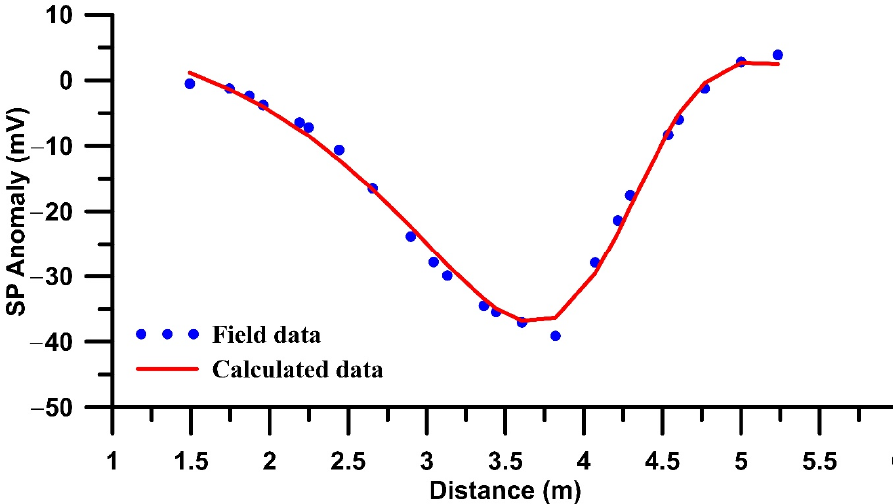
Figure 12. Fits for field data of Archaeological investigation, Halutza, Southern Israel.